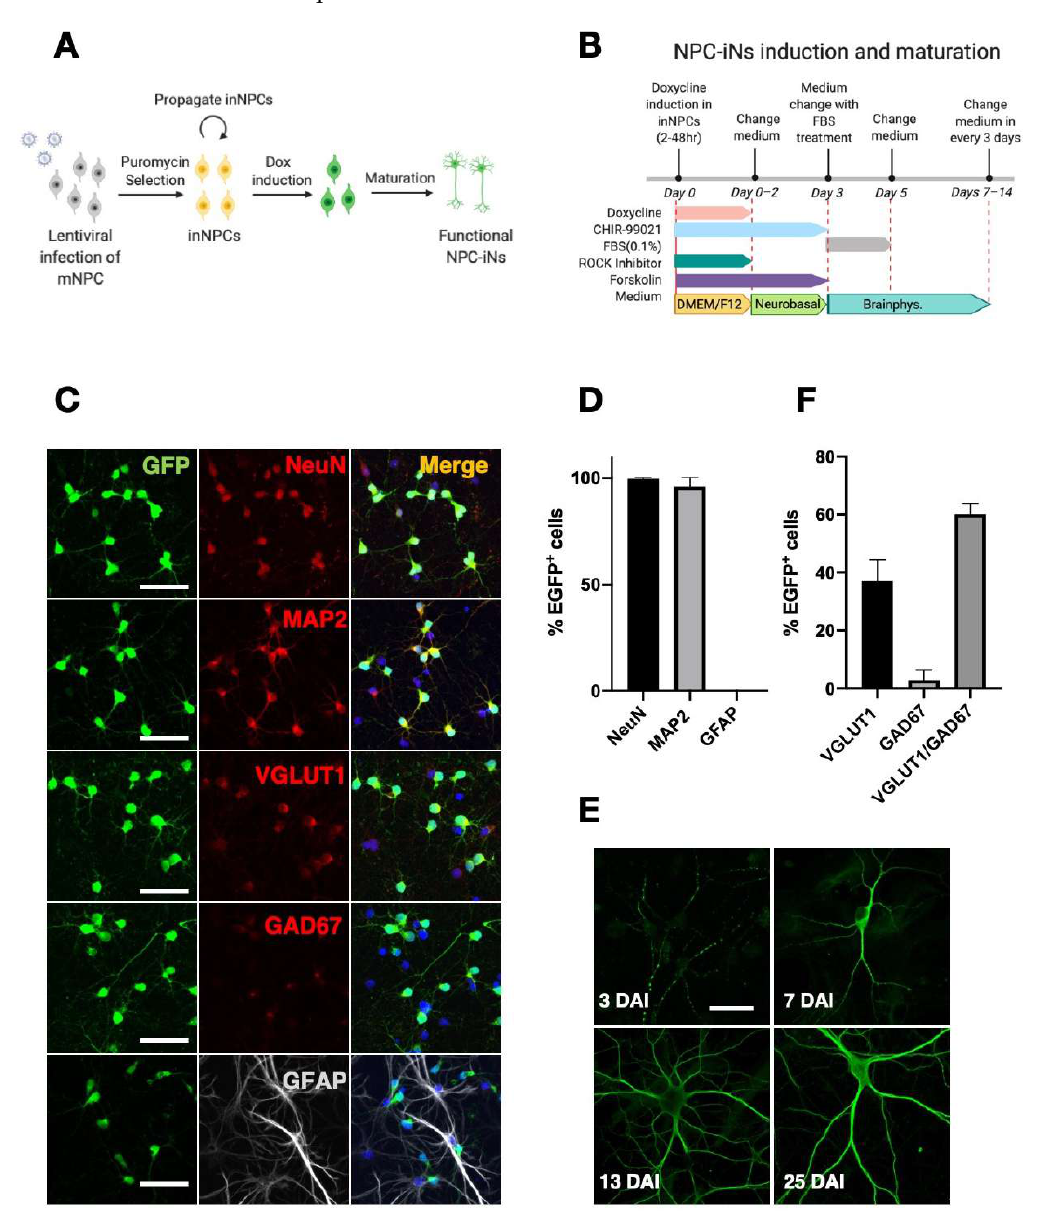
Figure 1. Differentiation of inNPCs into neurons. ( A ) A schema for generation of inNPCs and induction of NPC-iNs. ( B ) Experimental timeline for inducing and maturing NPC-iNs. ( C ) Characterizing differentiation of NPC-iNs at 7 DAI. EGFP + NPC-iNs at 7 DAI (green) stained with neuronal markers NeuN, MAP2 (red), an excitatory neuronal marker VGLUT1 (red), a GABAergic neuronal marker GAD67 (red) and an astrocytic marker GFAP (white). Scale bars = 50 µ m. ( D ) Quantification of the fraction of EGFP + NPC-iNs coexpressing NeuN (N = 262 cells, 99.6 ± 0.6%), MAP2 (N = 311 cells, 96.1 ± 4.1%) or GFAP (N = 260 cells, 0 ± 0%). ( E ) Quantification of the fraction of EGFP + NPC-iNs coexpressing only VGLUT1 (N = 688, 37 ± 7.3%), only GAD67 (N = 688, 2.9 ± 3.5%) and both VGLUT1 and GAD67 (N = 688, 60.1 ± 3.9%). ( F ) NPC-iNs at 3 DAI, 7 DAI, 13 DAI, and 25 DAI stained with MAP2 to show morphological development over time. Scale bar = 25 µ m. All quantifications correspond to three independent experiments. Data are presented as mean ±